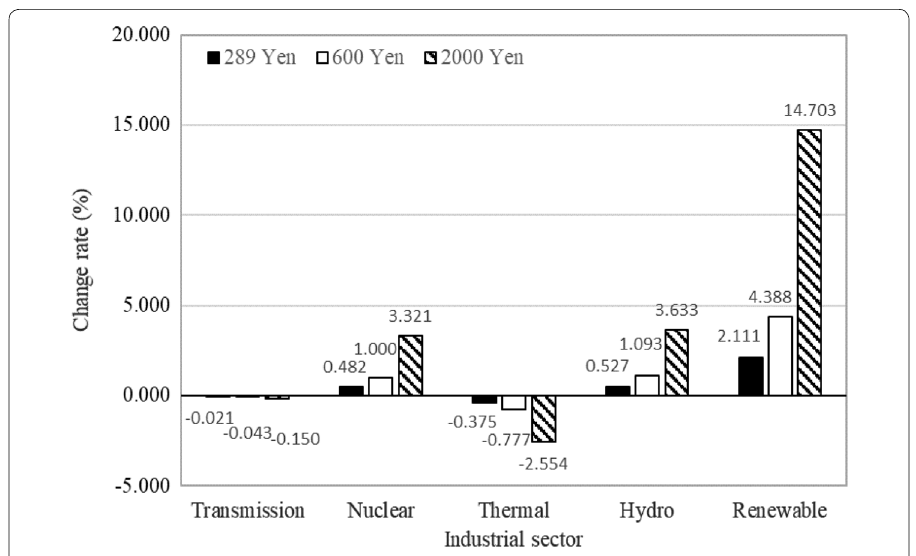
Fig. 4 The change rate of electricity generation in scenario 2